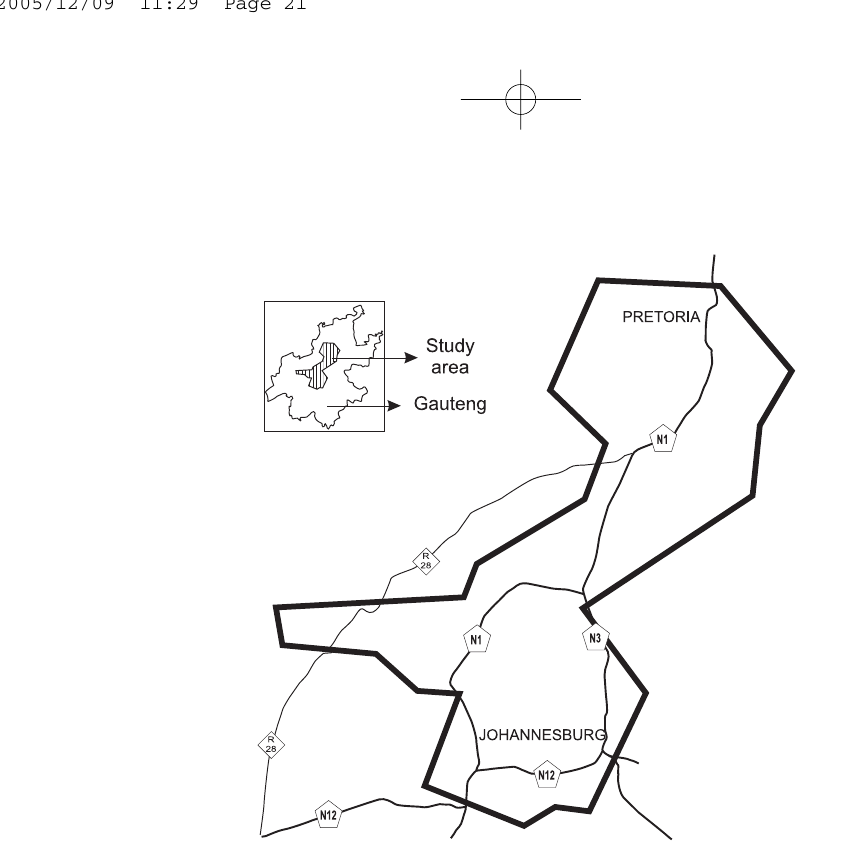
Fig. 1. Location of the study area within the Gauteng